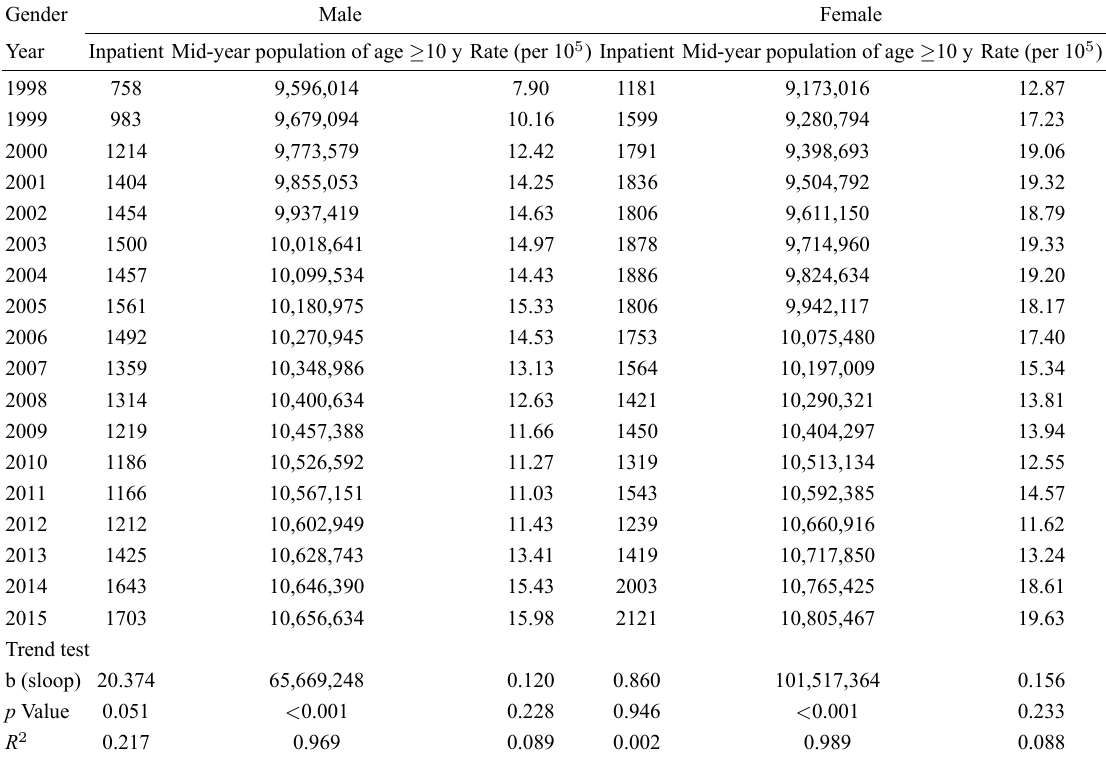
Table 3. Factors of suicide prognosis using multivariable logistic regression. Gender Male